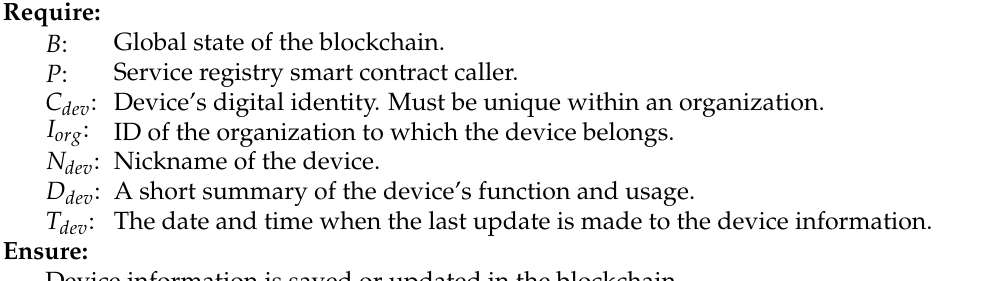
Algorithm 1 Registering a device with the service